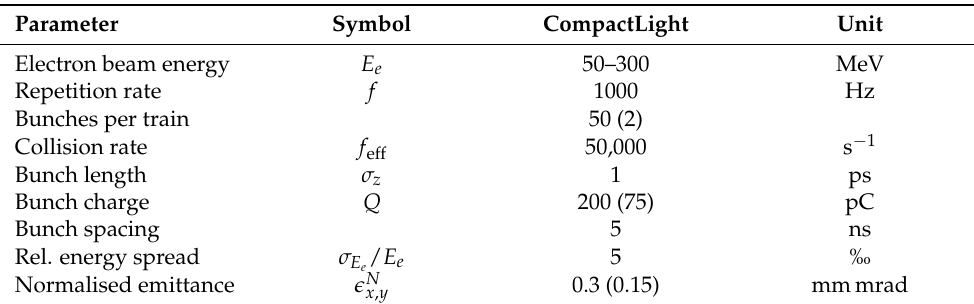
Figure 3. The 2.5 Cell C-band gun components and 3-D design. The solenoid, the mode launcher, the laser ports and the supports are visible. This 3-D representation was created by IASA, Athens, on a design made by INFN-LNF. Table 2. Baseline parameters of the CompactLight injector. Initial values, which were modified to increase the total flux, are marked in